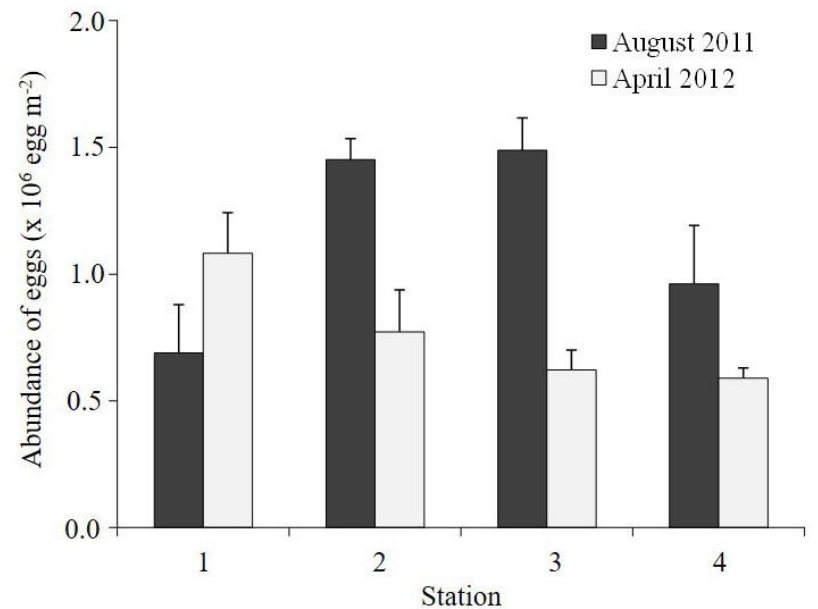
Figure 5. Copepod egg abundance in the sediment of Masan Bay in August 2011 and April 2012 (data are presented as the mean ± standard error).